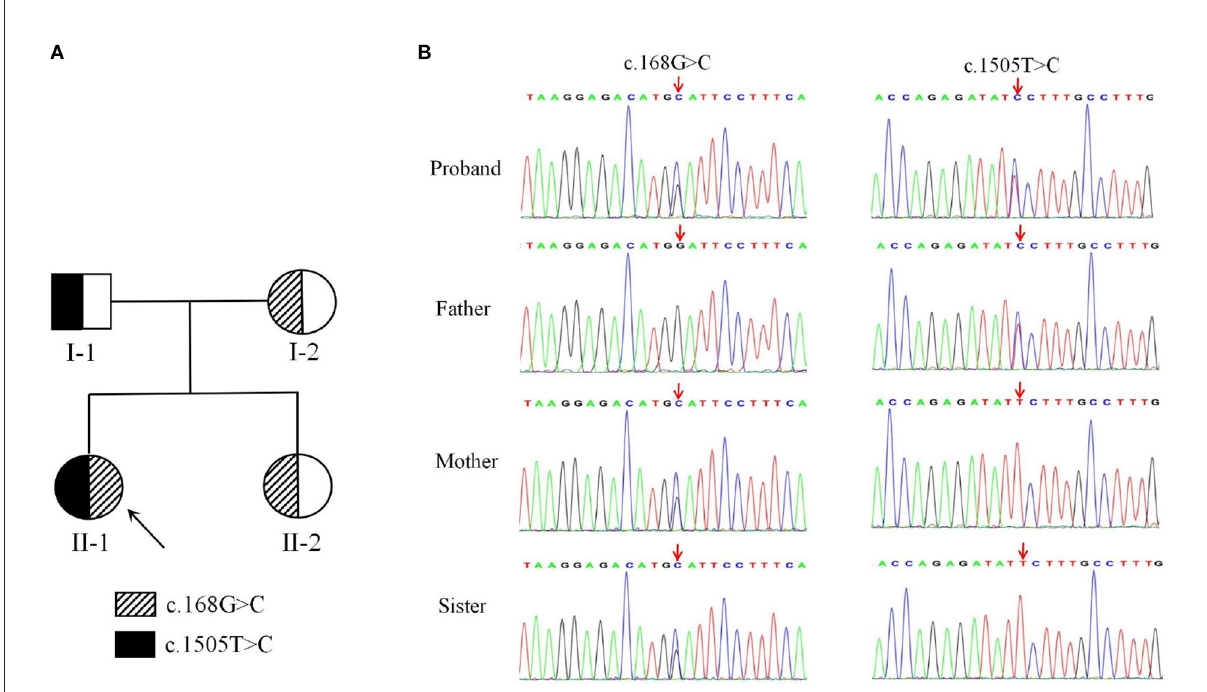
FIGURE2 A two-generation family pedigree and Sequencing results of DDHD2 . (A) Heterozygous individuals carrying either mutation are presented with half-filled shaded areas. The arrow indicates the proband. (B) Sequencing results showed that c.168G > C (p.Trp56Cys) was inherited from the mother, whereas c.1505T > C (p.Phe502Ser) was inherited from the